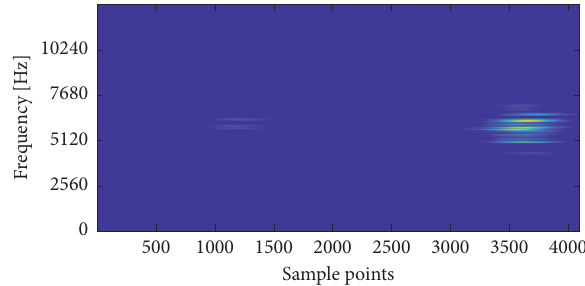
Figure 21: Time-frequency diagram of the cylinder vibration signal.